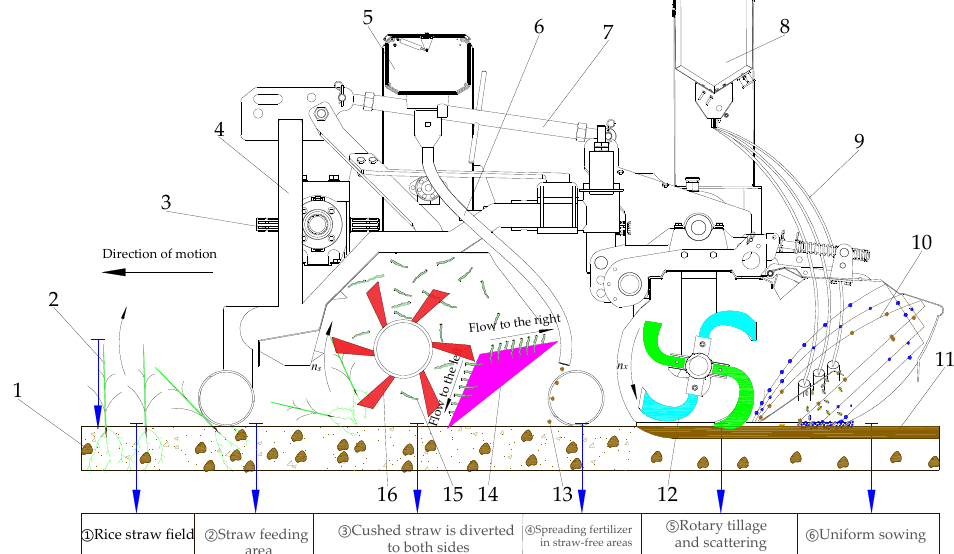
Figure 3. Working principle of wheat wide-seed-belt sowing and covering the soil test bed: (1) rough soil in non-rotary tillage area; (2) rice straw; (3) power input shaft; (4) rack; (5) fertilizer box; (6) fertilizer tube; (7) three-point suspension at the back; (8) seed box; (9) seed tube; (10) soil; throwing track; (11) fine ground soil after rotary tillage; (12) rotary tillage mechanism; (13) wheat; (14) strip laying device; (15) broken straw; (16) straw-crushing mechanism.